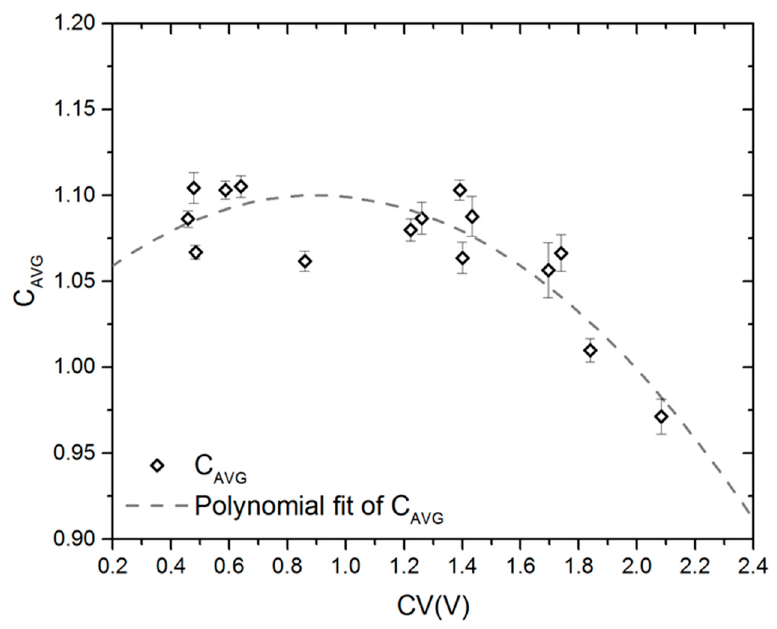
Figure 5. Average values of reduced Young’s modulus, E effAVG /E s ( ○ ), versus relative density and CV(V) calculated for the LVT aluminum open-cell structures and their xy ( ▪ ), yz ( ▪ ), and zx ( ▪ ) pro- jections.